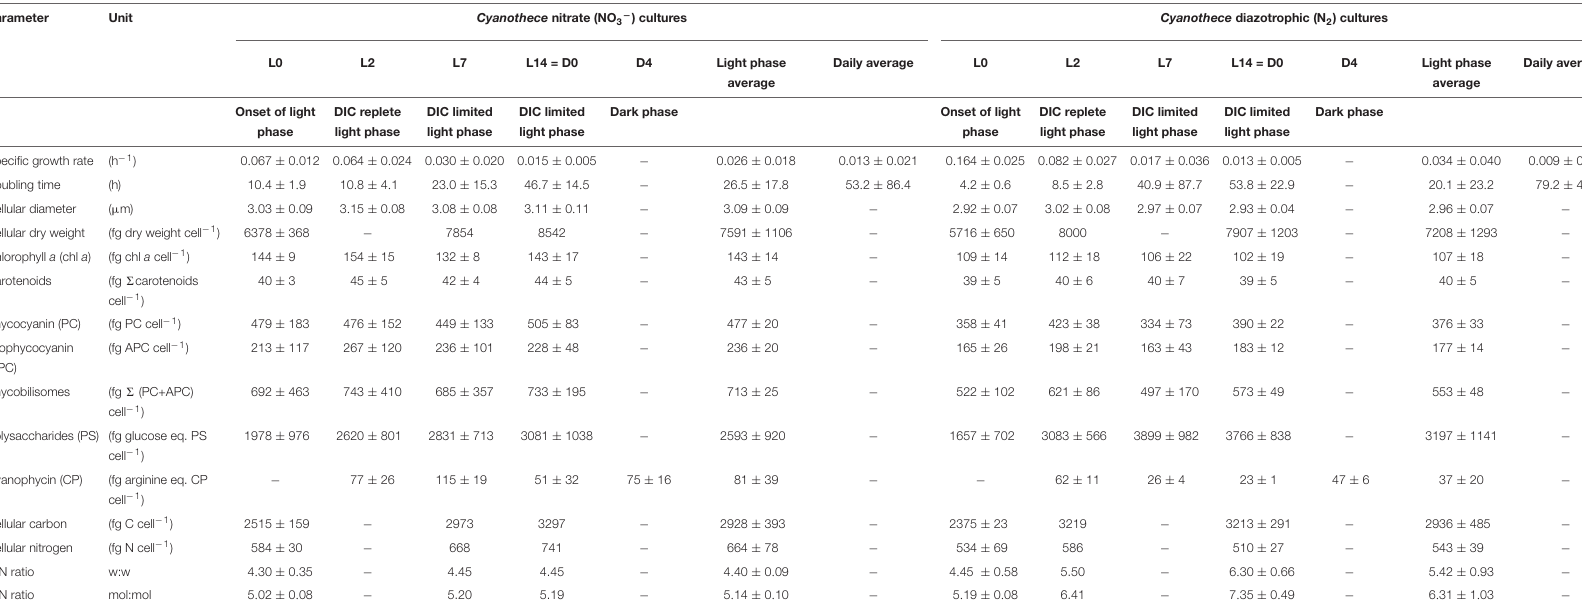
The four time points represent the onset of light phase (L0), DIC replete light phase (L2) and DIC limited light phase (L7, L14) (see Figure 1 ). Data represent averages from samples taken over successive days in 3 culture replicates, error intervals represent standard deviations. When no error intervals are available, n ≤